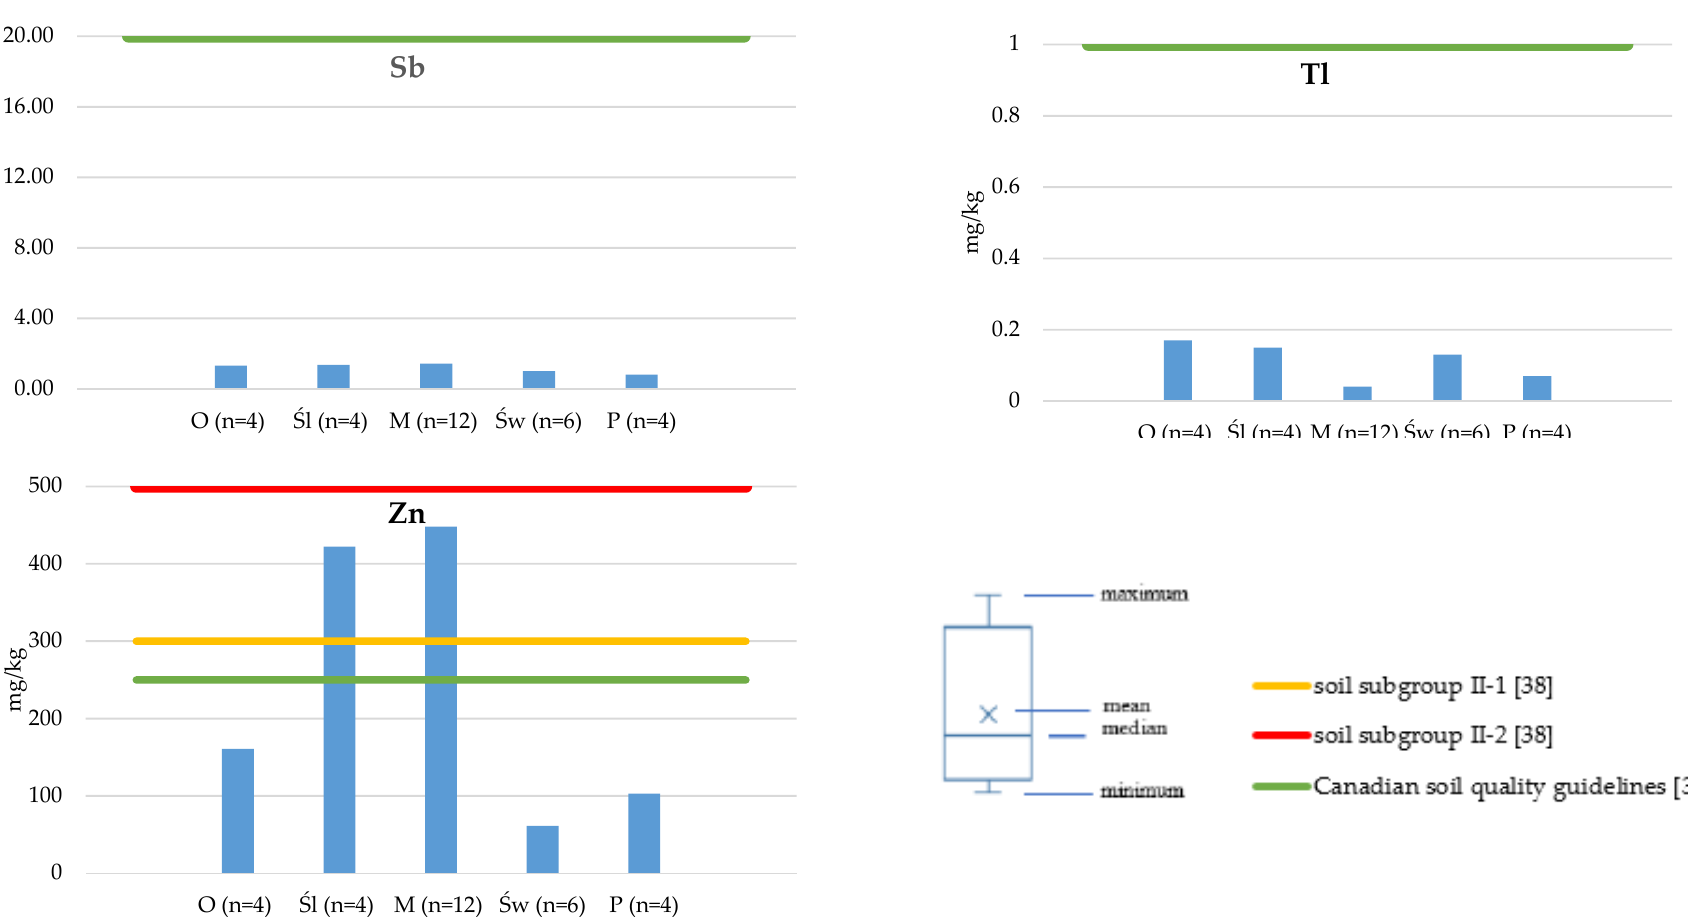
Figure 2. Pseudototal Potentially Harmful Element (PHE) contents in the agricultural soils in the Regions of southern Poland and soil quality; O—Opolskie, Ś l— Ś l ą skie, M—Ma ł opolskie, Ś w— Ś wi ę tokrzyskie, P—Podkarpackie.